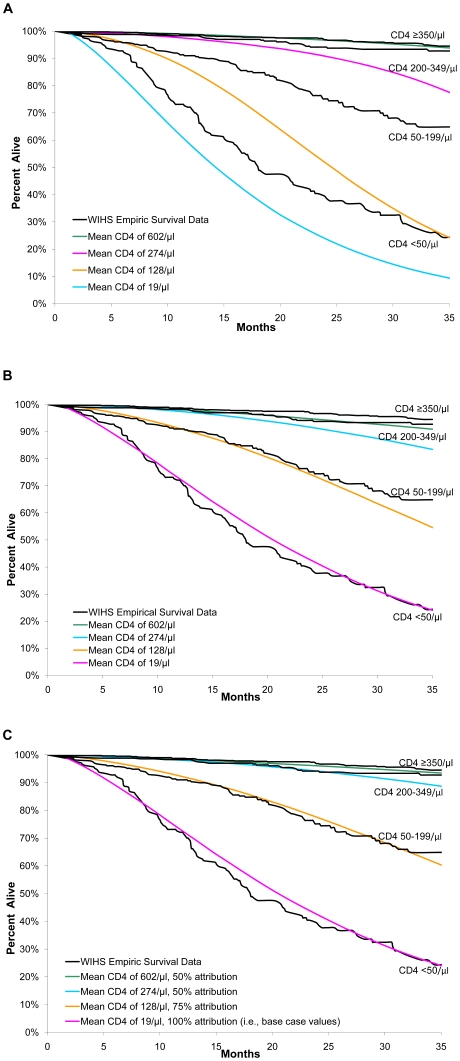
Base case natural history data with WIHS cohort characteristics.Part A of Figure 1 shows the model-estimated survival of the WIHS cohort using natural history input parameters derived from the MACS. With the exception of the highest CD4 stratum (CD4 ≥350/µl), the model underestimates survival for individuals with initial CD4 cell counts <350/µl, particularly as follow-up time increased. Part B of Figure 1 shows the base-case model-estimated survival using natural history input parameters derived from the WIHS. The re-parameterized model more closely approximates the empiric data for the three lowest CD4 strata (generally within the 95% CI), although the model continues to marginally underestimate mean survival in CD4 strata CD4 50–199/µl and CD4 200–349/µl. Model-projected survival in the highest CD4 stratum (≥350/µl) is more significantly underestimated, with a better visual fit achieved using natural history inputs derived from the MACS (Figure 1, Part A). Part C of Figure 1 shows the impact of adjustment of CD4-specific attribution on model-projected survival. Part C of Figure 1 demonstrates that better consistency between model-projected survival and empiric data was best achieved with adjustment of CD4 stratum-specific attribution. Specifically, reduction of the incrementally increased probability of AIDS-related mortality in patients with a history of previous opportunistic infections (attribution) by 25% for CD4 50–199/µl and 50% for CD4 strata ≥200/µl resulted in better estimation of the empiric survival data.